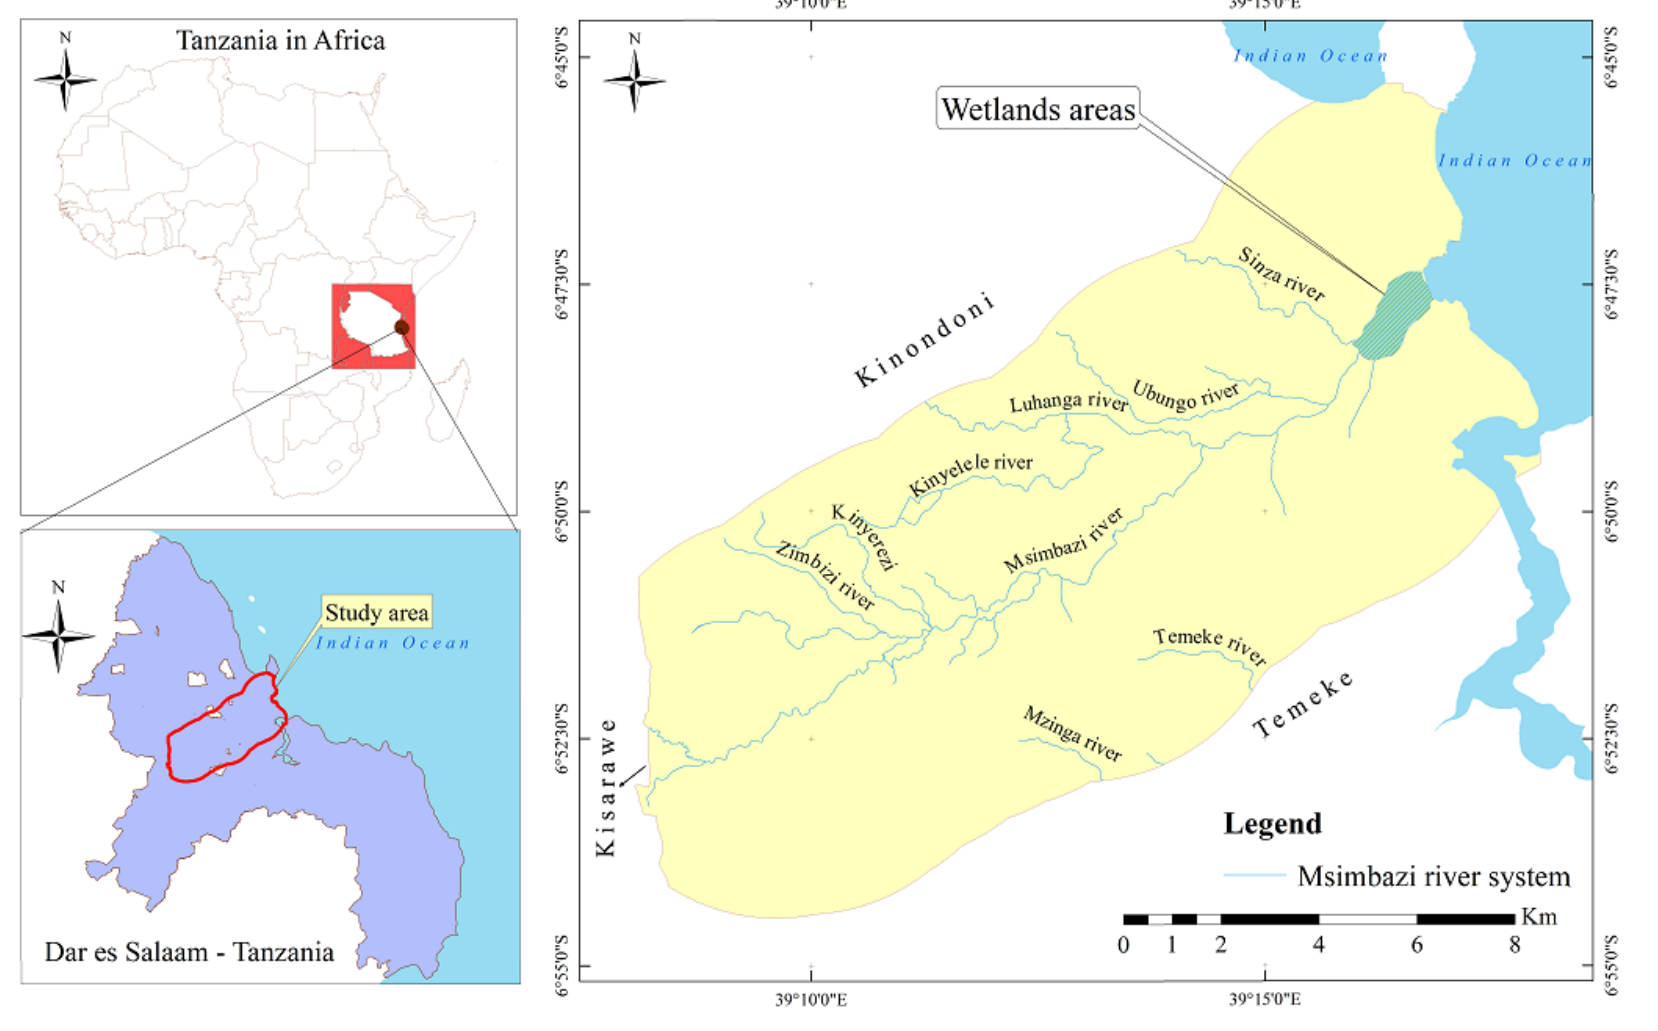
Figure 1. Map of Dar es Salaam showing location of the study area.